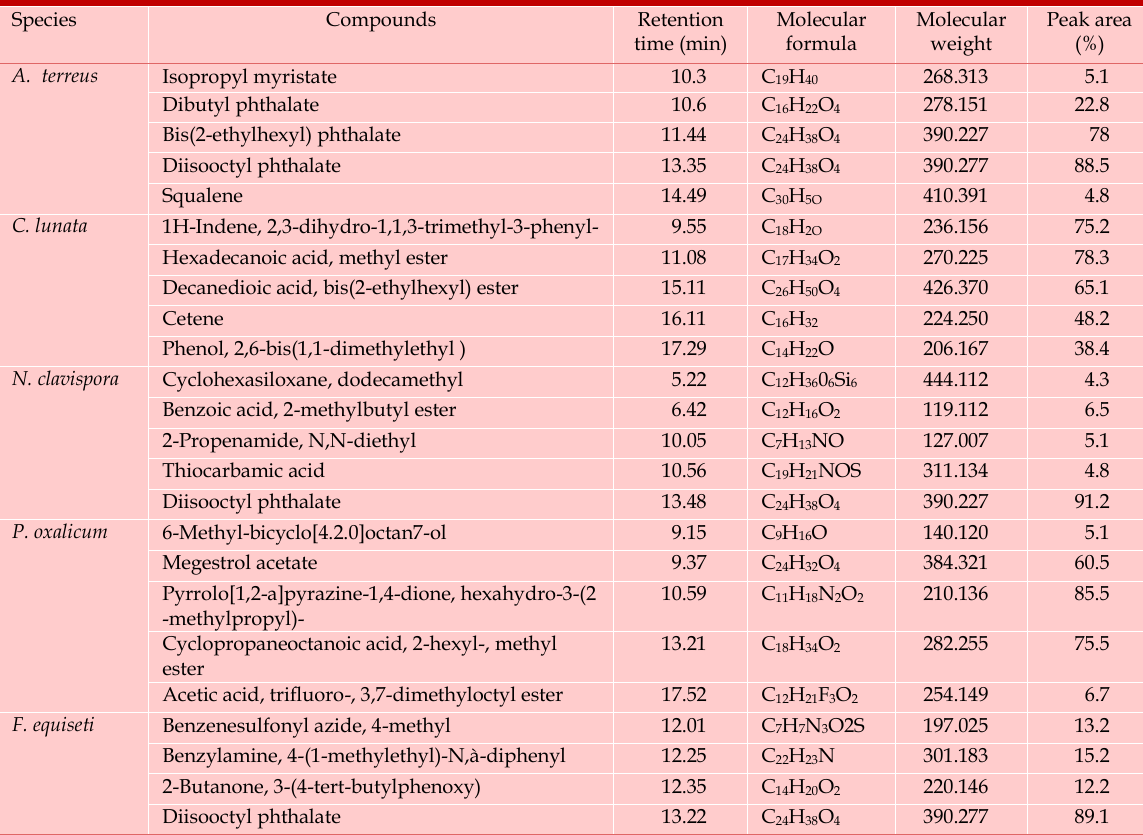
Compounds identified from the extracts of endophytic fungal strains by GC-MS analysis Species